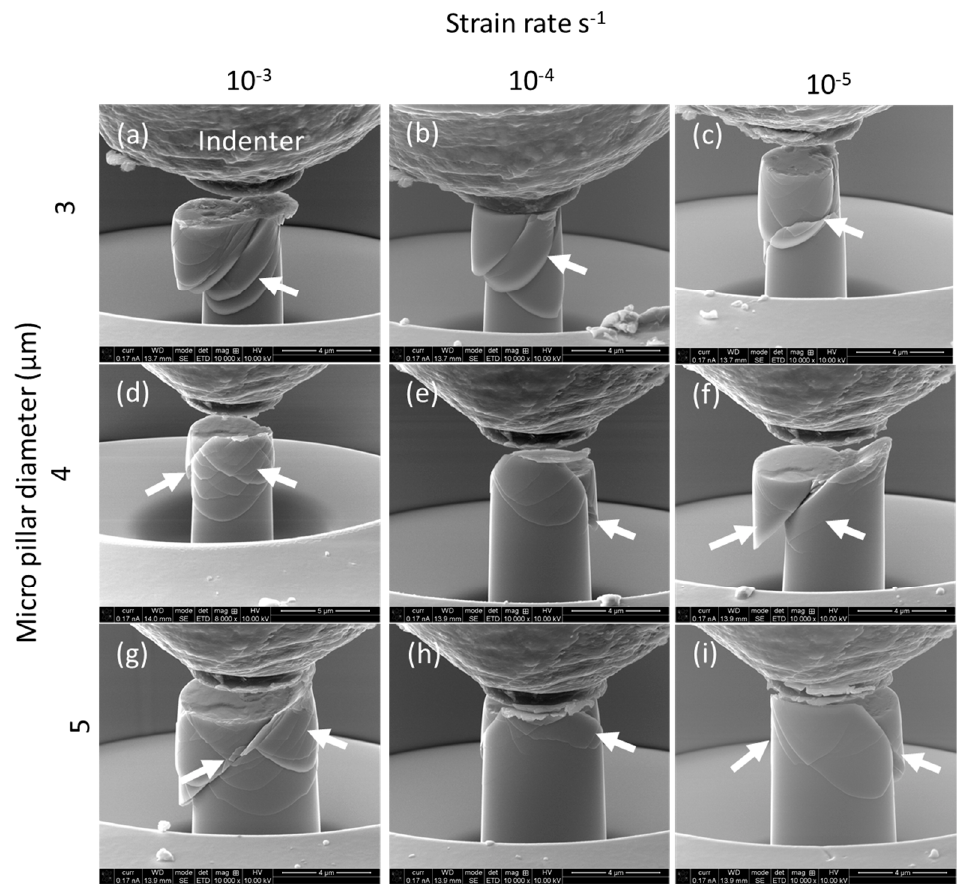
Figure 7. A 45° SEM view of deformed micro-pillars of different size after compression at different strain rate.